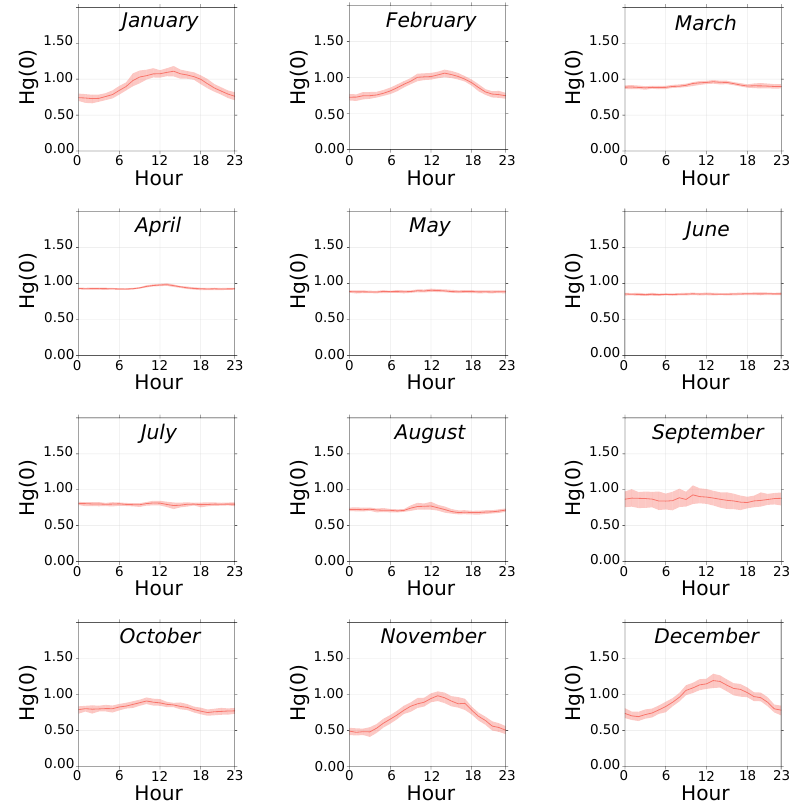
Figure 7. Monthly mean diurnal cycle of Hg(0) concentrations (in ngm − 3 ) along with the 95% confidence interval for the mean, calculated from all the data collected at DDU (January 2012–May 2015). Hours are in local time (UTC + 10). Hg(0) concentrations exhibit a strong diurnal cycle in summer